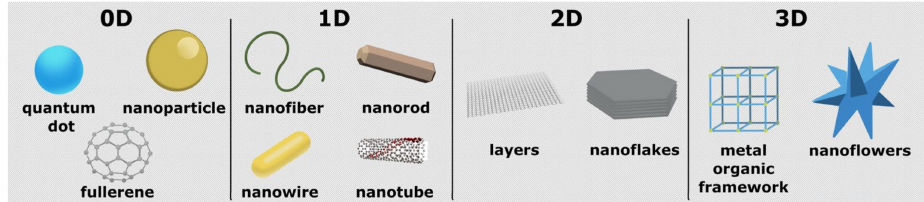
Figure 2. Illustration of some 0–3D nanostructured material